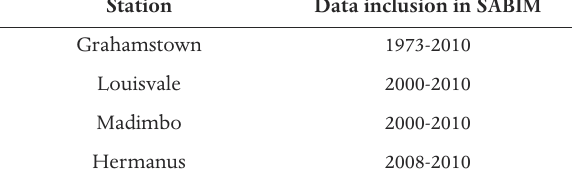
Table 1. Time range of ionosonde data used in training